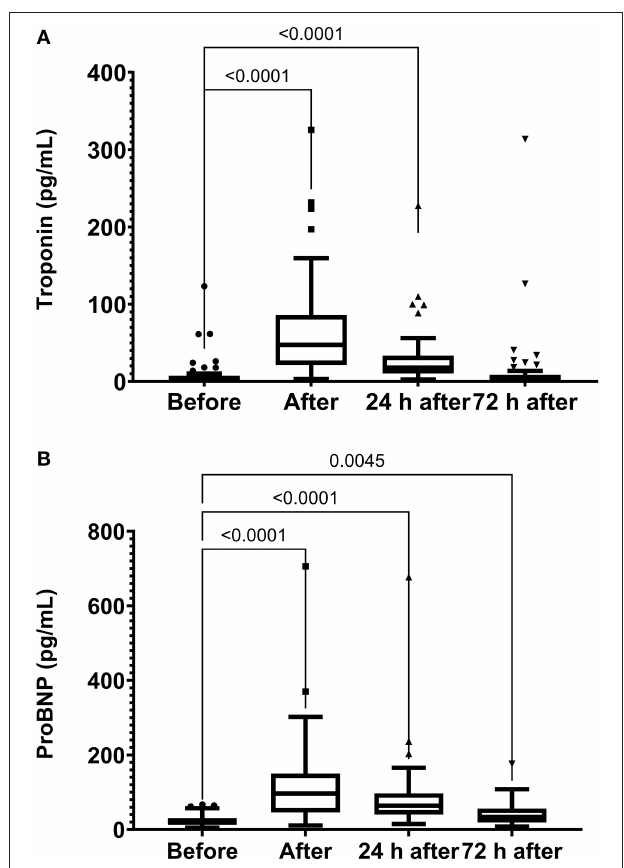
FIGURE 2 | Troponin (A) and NT-proBNP (B) levels immediately after, 24h after, and 72h after the race. N-Terminal pro B-type natriuretic peptide, proBNP. The values are presented as minimum, maximum, median, and outliers of 53 runners (Box plot, Tukey).